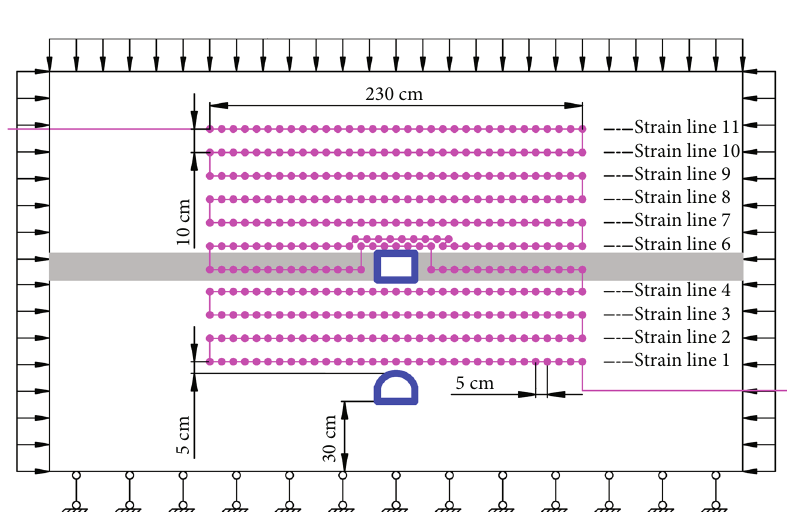
Figure 6: Strain measuring line and monitoring point layout plan of distributed optical fi ber.